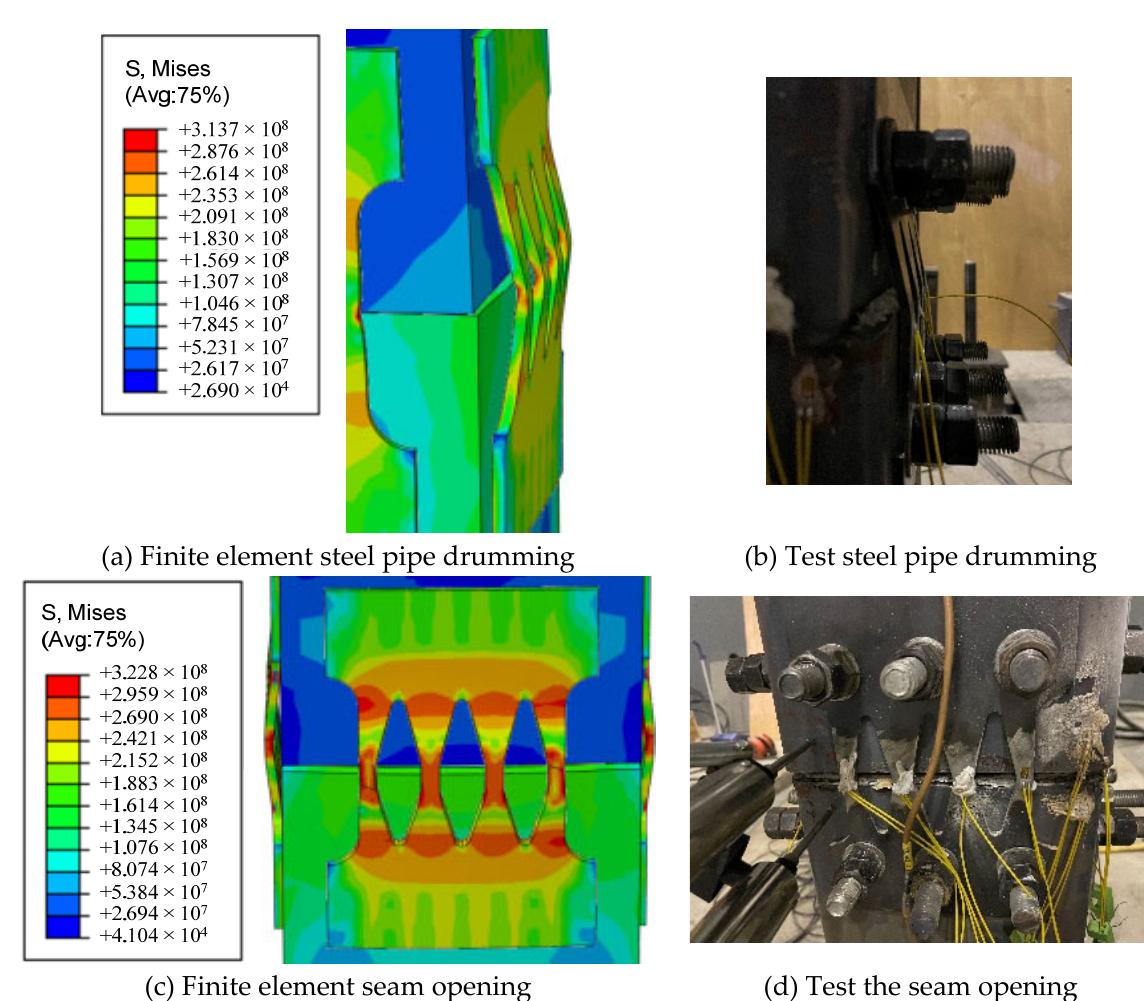
Figure 9. Comparison of stress distribution and deformation. Table 3. Comparison between simulation results and test results.